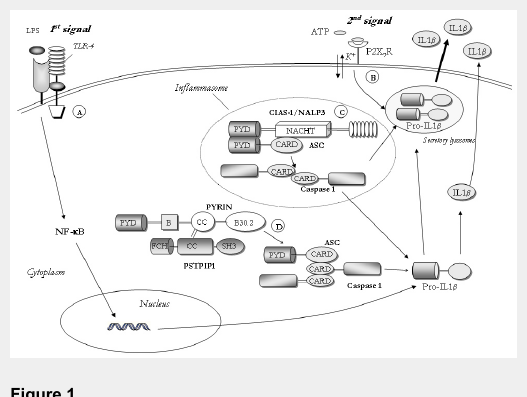
Figure 1 Role of NOD2/CARD15 in the activation of NF-κB and caspase